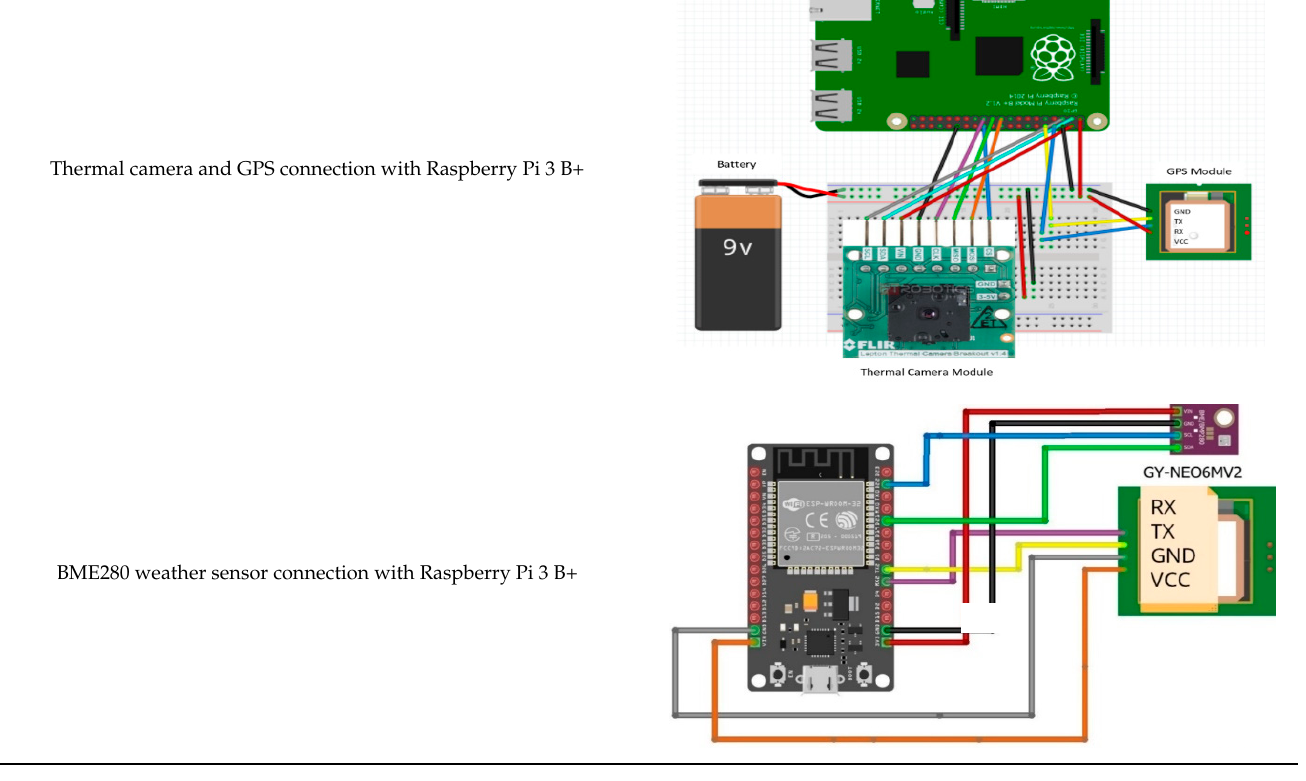
Table 2. The configurations of the experiment’s